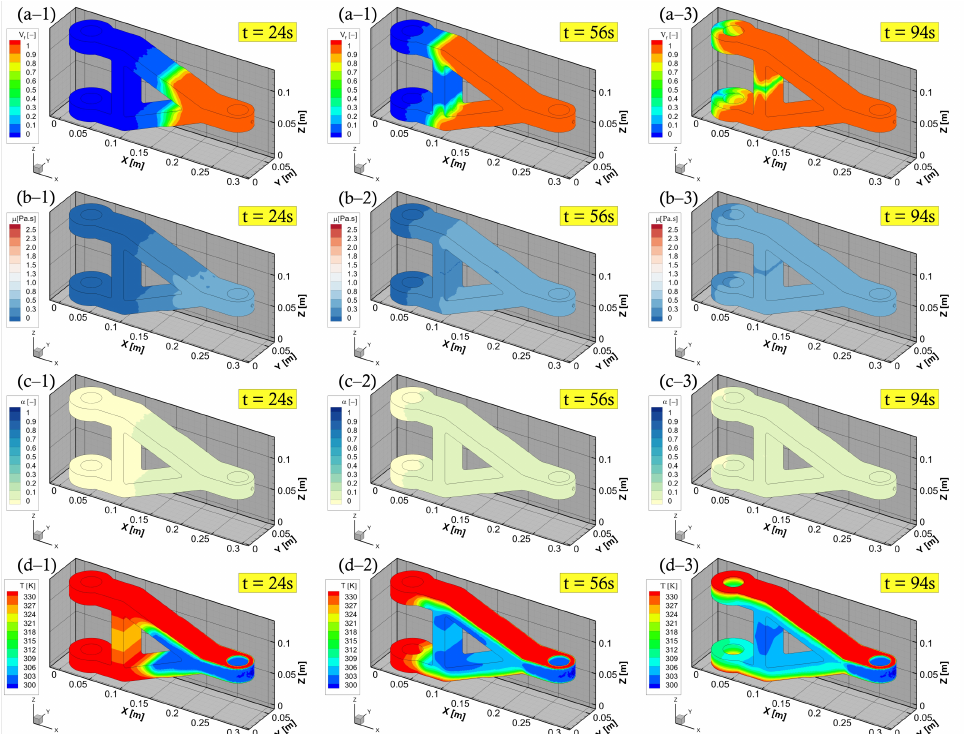
Figure 9. Filling stage of the torque link: ( a ) resin impregnation; ( b ) viscosity changes; ( c ) degree of cure; and ( d ) temperature distribution.